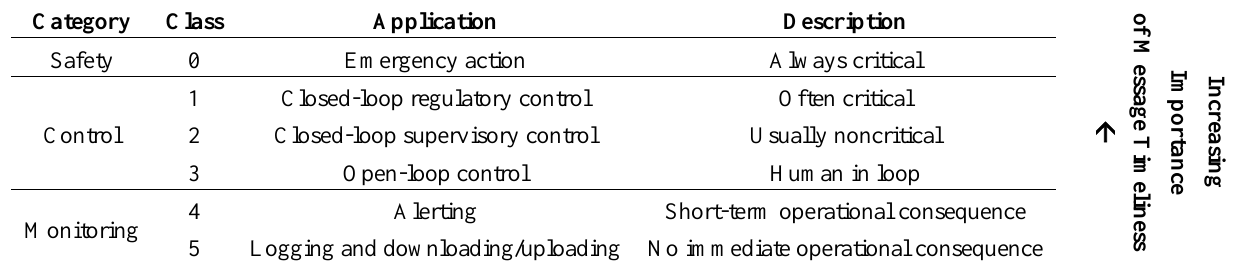
Table 1. Different classes of applications as defined by